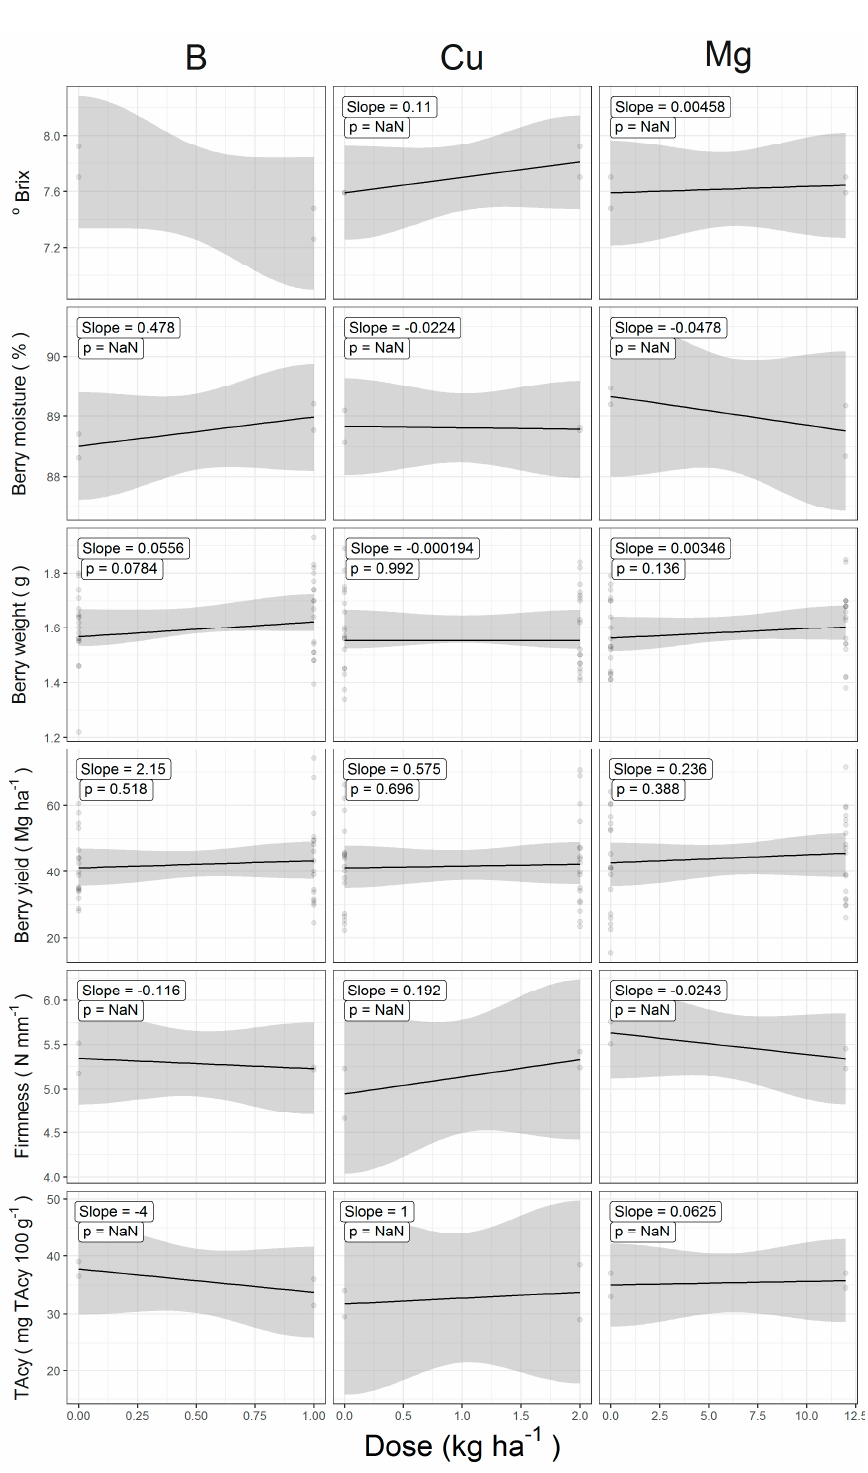
Figure A2. Response of cranberry yield components to added B, Cu, and Mg. The solid line represents the model fit with the slope and intercept of the line; the shaded area rep- resents the 95% confidence interval.